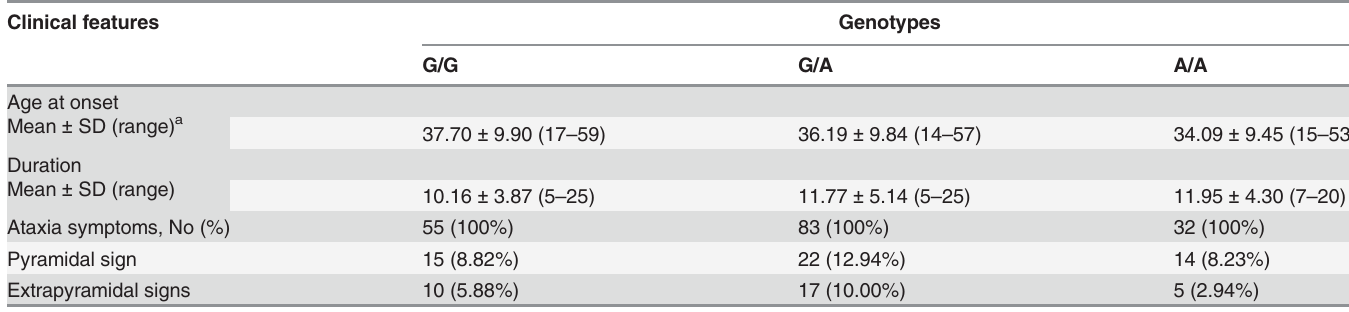
Table 1. Clinical presentations of SCA3/MJD